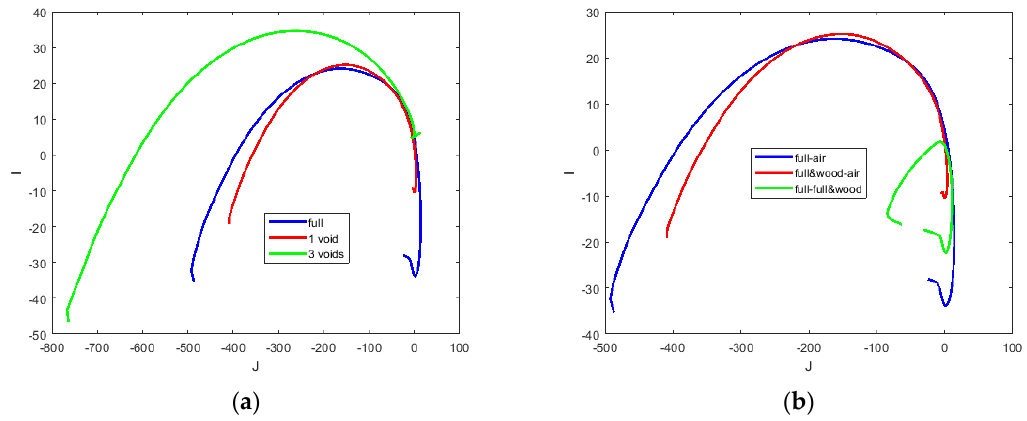
Figure 26. ( a ) Complex plot of the impedance for inclusions; ( b ) focusing on one void, but various background data.